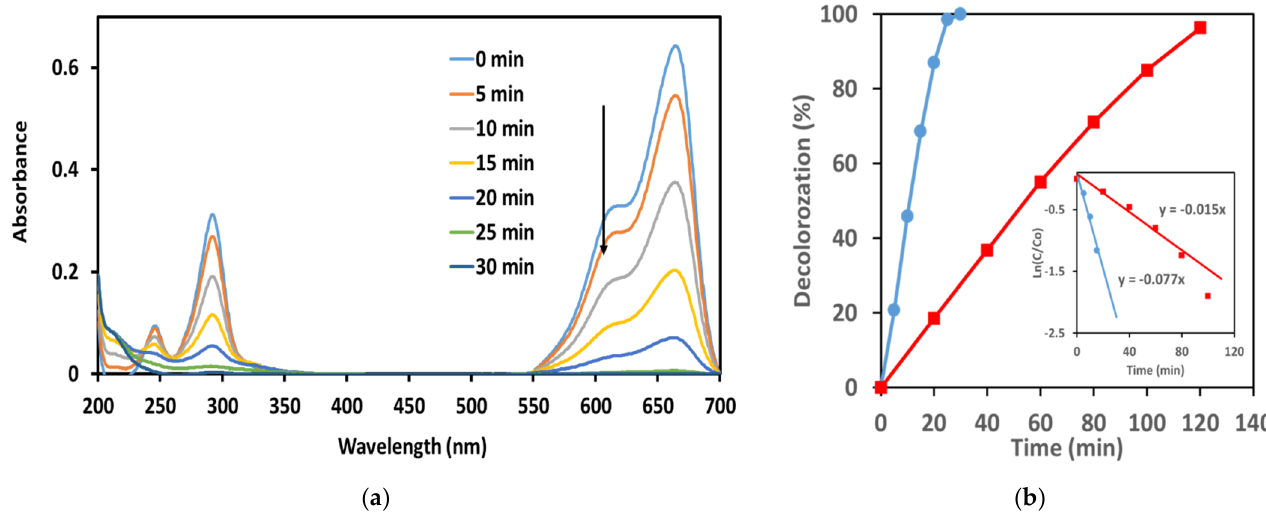
Figure 5. ( a ) UV-Vis spectra of MB during the electrochemical oxidation process with Ti/α-PbO 2 /β-PbO 2 . ( b ) Decolorization efficiency of MB with Ti/α-PbO 2 /β-PbO 2 (blue) and Ti/α-PbO 2 (red). Na 2 SO 4 electrolyte: 0.05 mol L −1 ; reaction time: 2 h; electrode distance: 3 cm; initial pH: 6.0; reaction temperature: 25 °C; MB: 3 mg L −1 ; and cell voltage: 20 V.